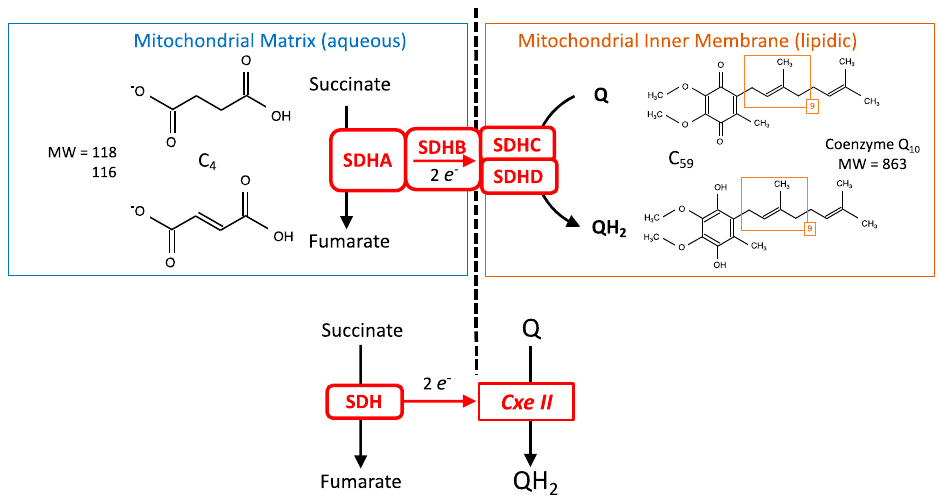
Figure 3. SDH ( Top ): Schematic representation of SDH subunits with the formulas of the substrate (succinate) and product (fumarate), as well as that of the electron acceptor, the oxidized Coenzyme Q 10 . ( Bottom ): Functional scheme with an “SDH side” and a “complex II side”.